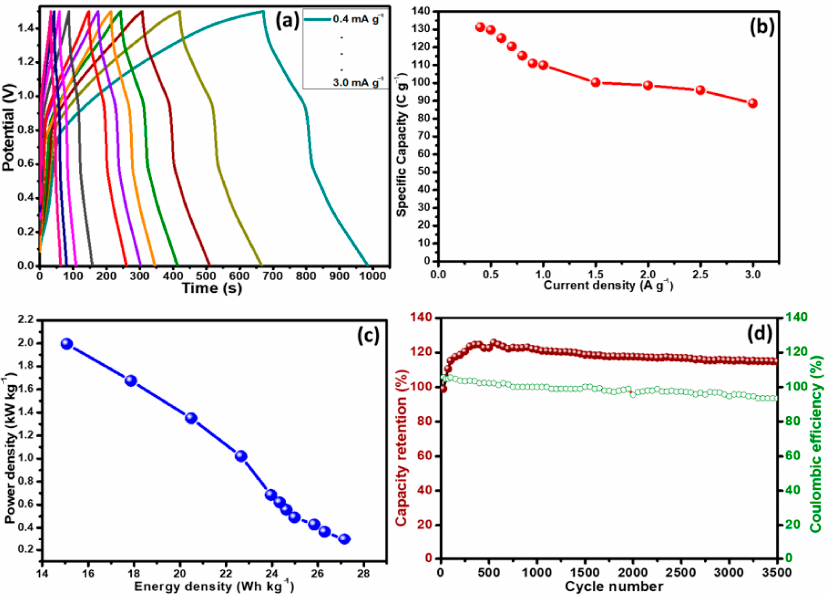
Figure 9. ( a ) GCD plot of PANI@CNT/MnO 2 ternary composite for the assembled hybrid device, ( b ) current density versus specific capacity, ( c ) energy density versus power density change, and ( d ) cyclic performance and coulombic efficiency of the PANI@CNT/MnO 2 ternary composite based hybrid device as a function of the number of cycles at a current density of 3.0 A g − 1 in 0.1 M KOH. Table 1. Polyaniline based composite electrode materials for supercapacitors.